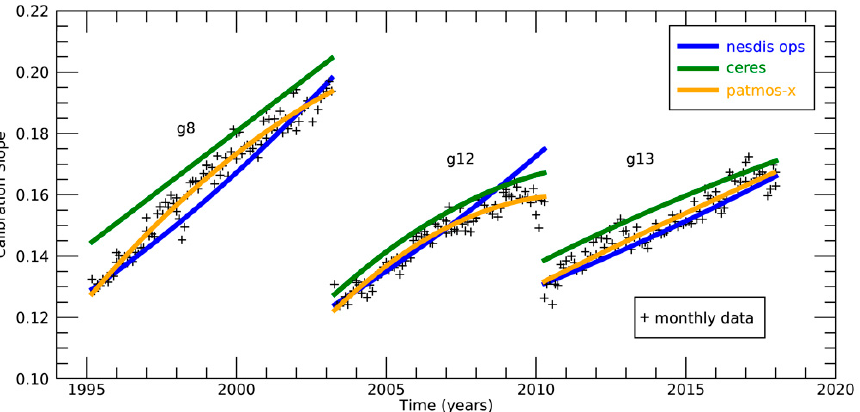
Figure 5. Comparison of calibration slopes. Blue line is the NESDIS operational value. Yellow line is the PATMOS-x fit derived here. Each thin black line represents the slopes computed directly for each month of the year from each satellite, which is the basis of the PATMOS-x calibration fits.